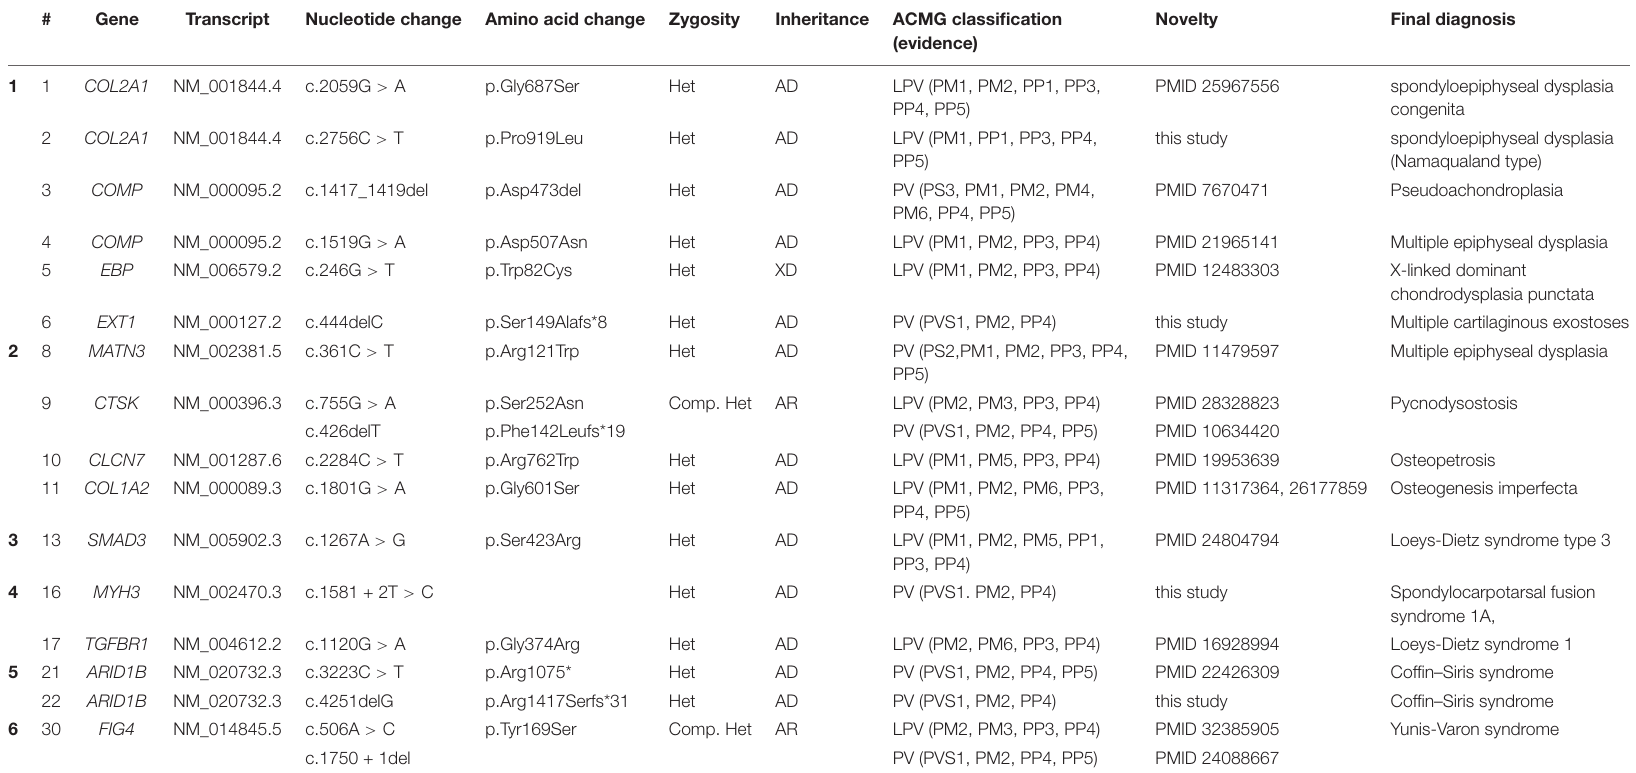
TABLE 3 | Genetic variants of 16 patients with a confirmed